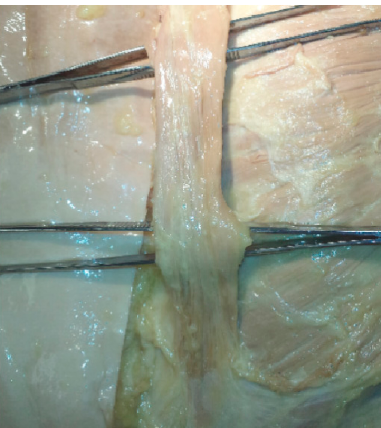
Figure 2. Photograph of M sternalis exposed during routine dissection in human gross anatomy laboratory; 25 cm forceps were used to indicate scale. Photograph by AJ Petto.